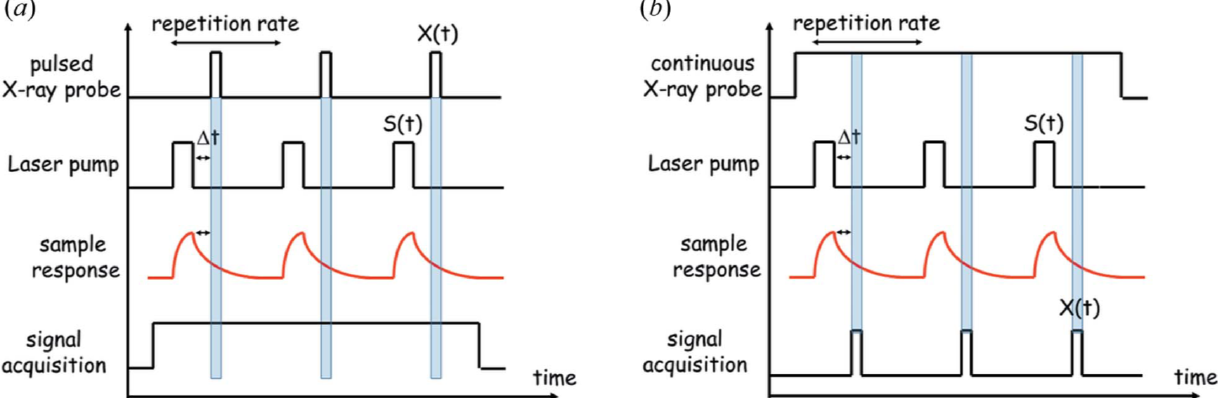
Figure 6. Two possibilities of performing time-resolved X-ray experiment: ( a ) with a pulsed X-ray source and a conventional detector, and ( b ) with a continuous X-ray source and a fast-gated detector. Figure reproduced with permission of the International Union of Crystallography from Casaretto et al. [85].